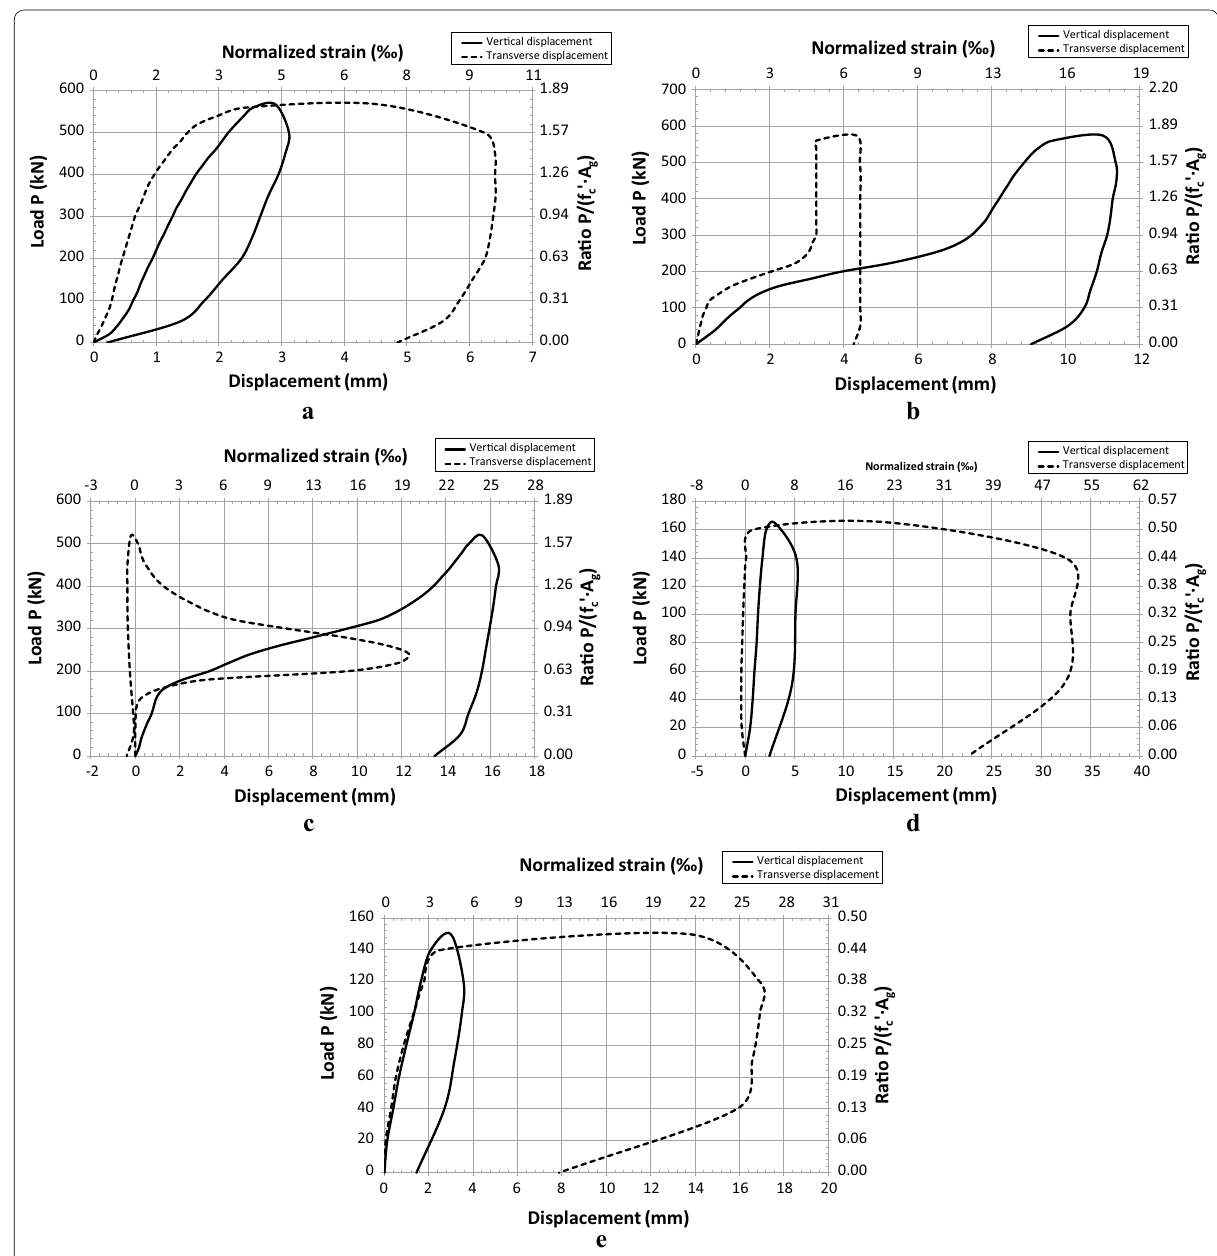
Fig. 3 Diagrams of compressive load versus vertical and transverse deformation for test specimens: a C-0, b C-10, c C-20, d C-30, e